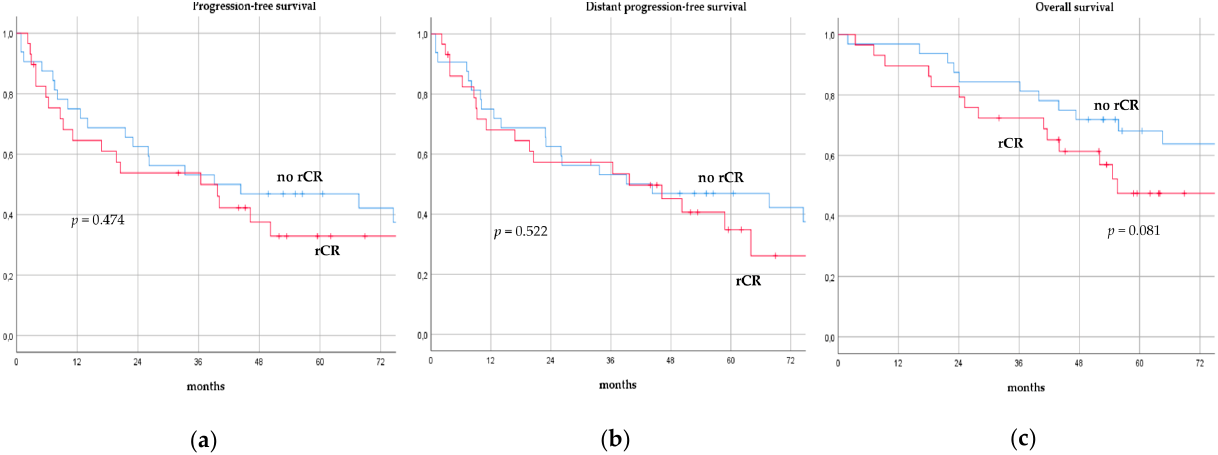
Figure 4. Progression-free survival ( a ), distant progression-free survival ( b ), and overall survival ( c ) curves of de novo metastatic breast cancer patients according to radiologic response after front-line chemotherapy. rCR: Radiologic complete response.